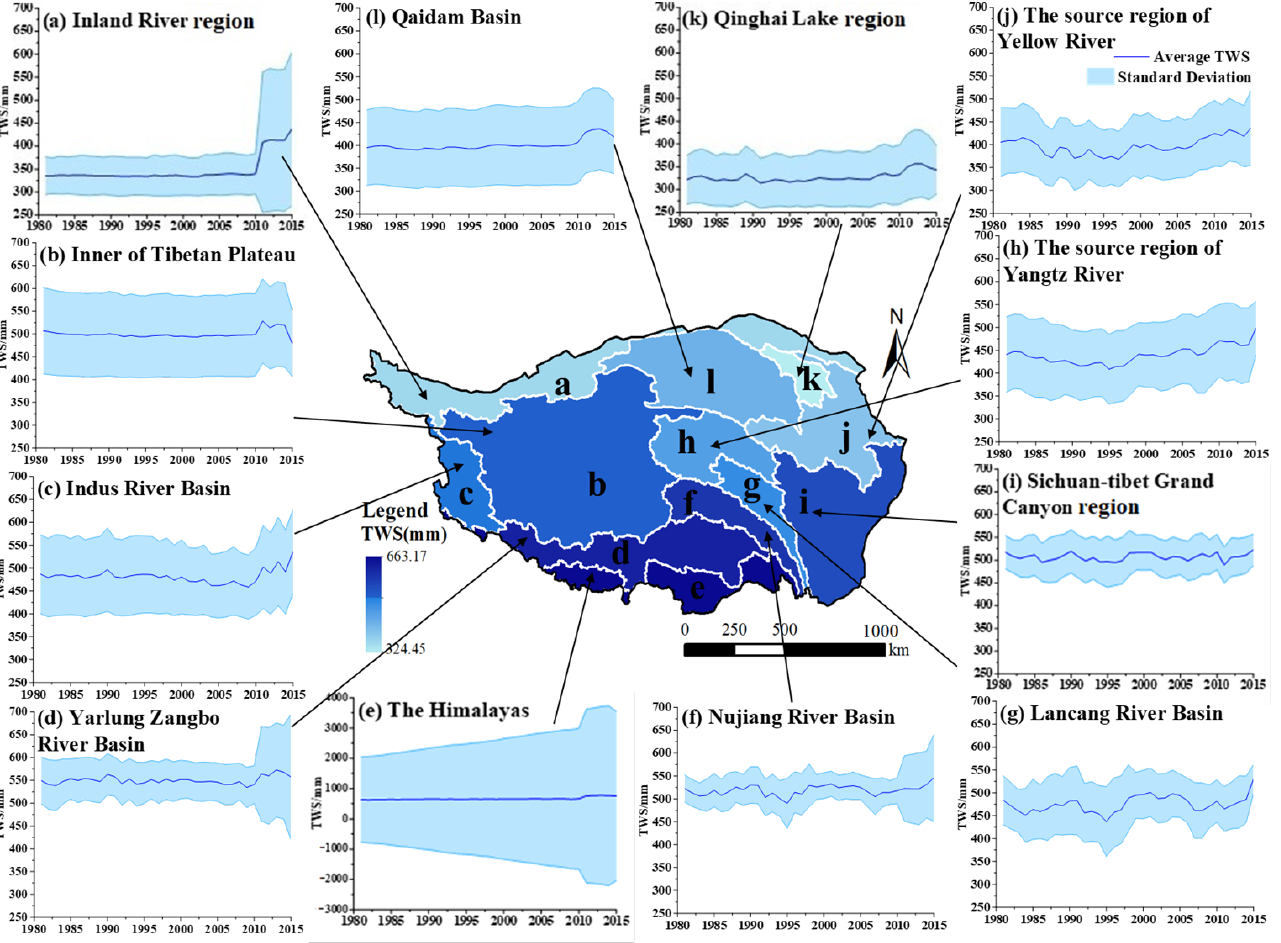
Figure 4. Temporal trend in terrestrial water storage for each sub-region over the Tibetan Plateau during the period